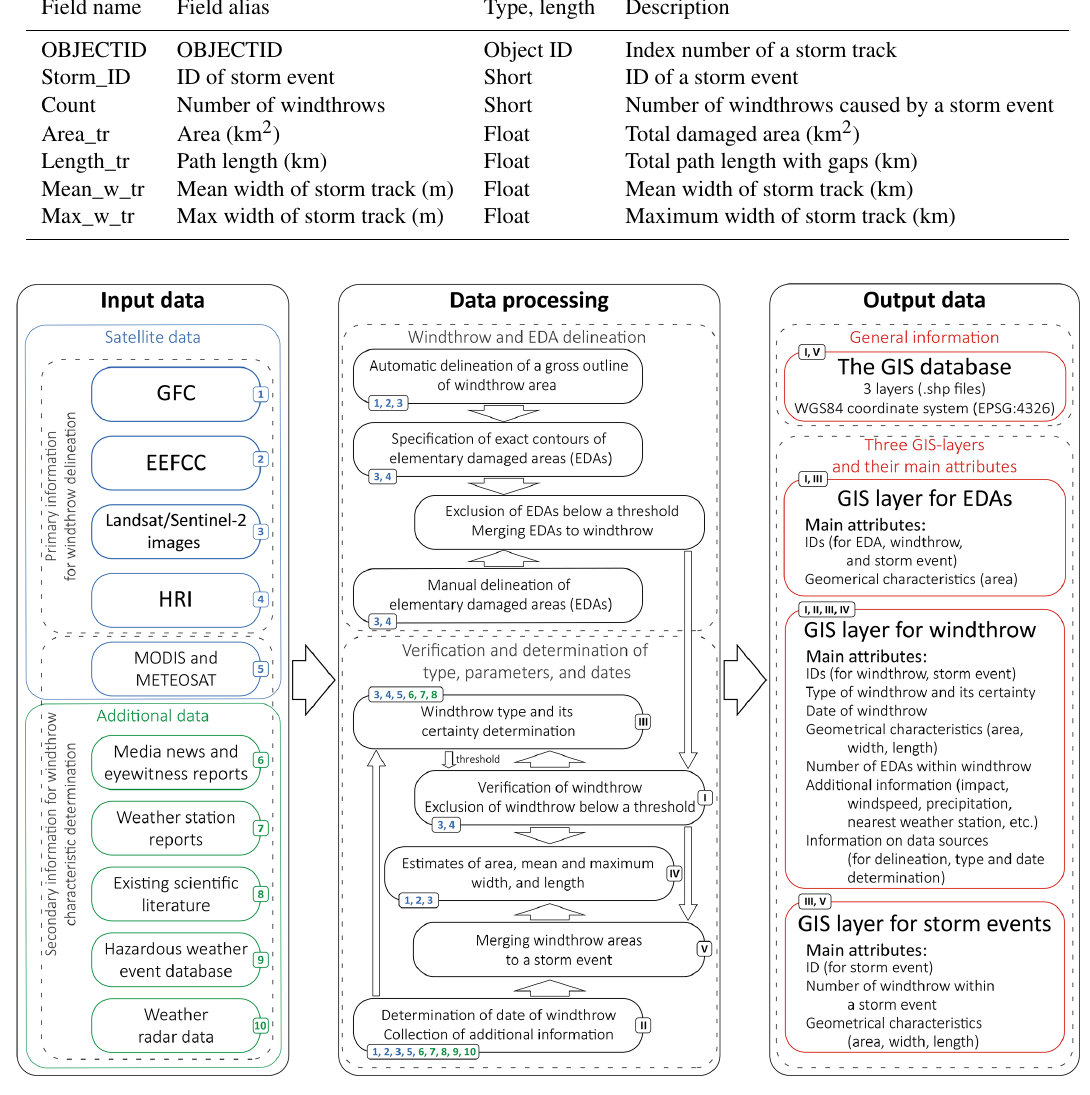
Figure 2. The workflow used for windthrow delineation and